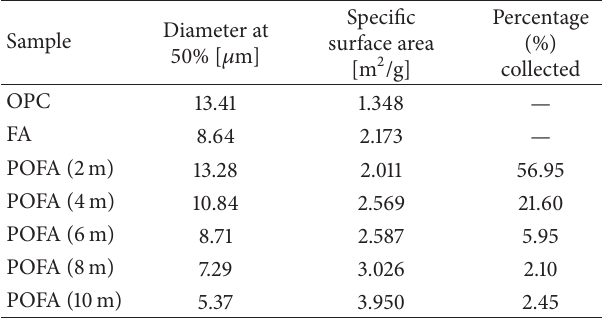
Table 1: Samples sizes from PSA